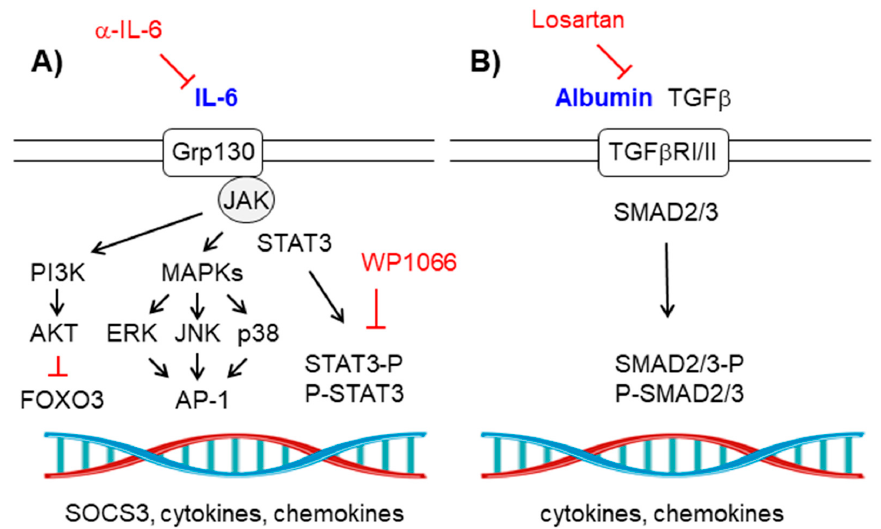
Figure 4. ( A ) Interleukin (IL)-6/Grp130-JAK-STAT signaling pathway. Schematic view of the are in blue. Therapeutic strategies to prevent the pathway are in red. ( B ) Albumin-TGF β / TGF β -RI / II signaling pathway. Schematic view of the components of the pathway. See text for details. Components See text for details. Components of the pathway that are increased in epilepsy are in blue. are in red. Pointed arrows indicate direction of the signaling pathway. Blunt arrows indicate